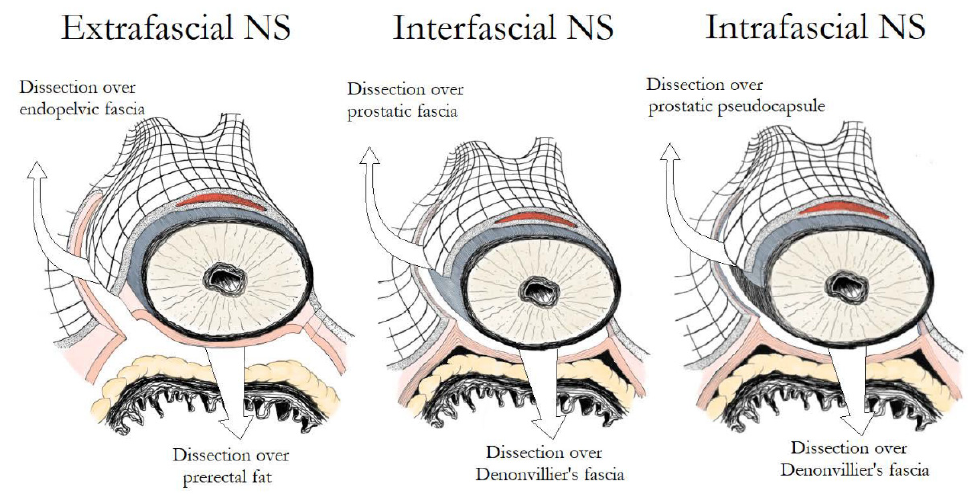
Figure 2. Main differences in fascial development between extrafascial, interfascial and intrafascial nerve-sparing.